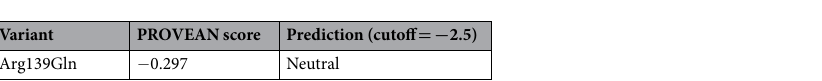
Table 4. PROVEAN analysis of SPRN nonsynonymous SNP in Korean native black